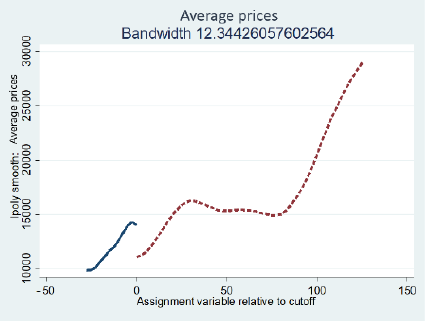
Figure 2. Impact of the 2008 financial crisis Table 3. Impact of the 2008 financial crisis using parametric and non-parametric models